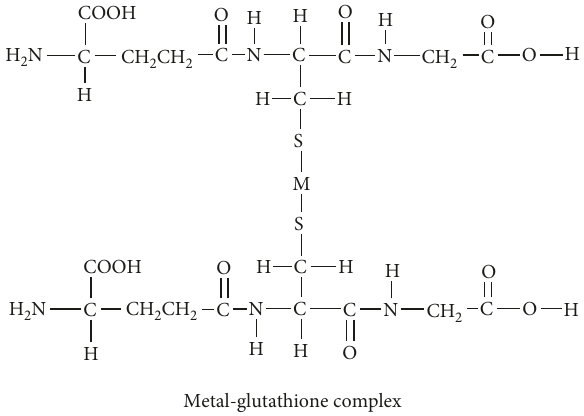
Figure 5: Reaction of a metal with glutathione (adapted from